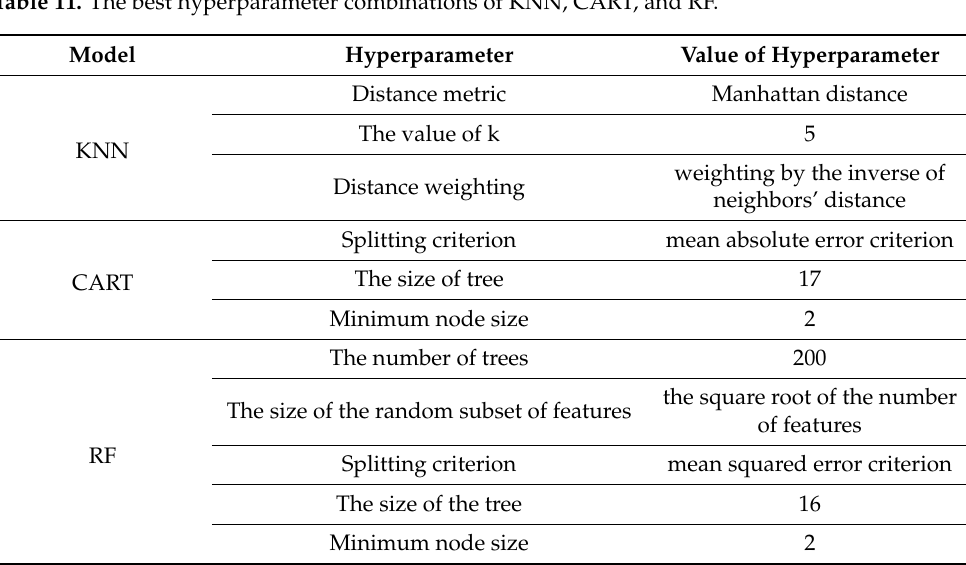
Table 11. The best hyperparameter combinations of KNN, CART, and RF.